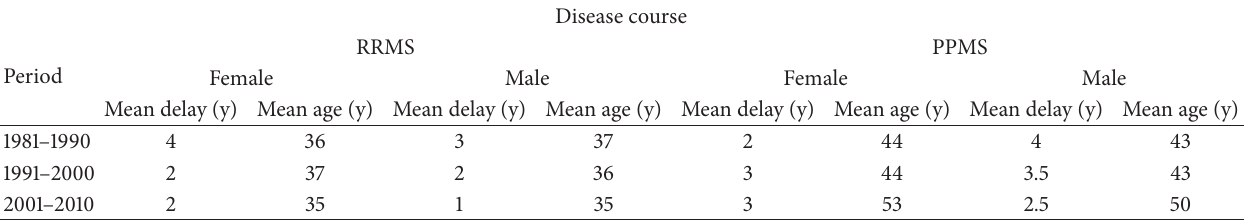
Table 3: Mean age at diagnosis and diagnostic delay (years) presented by disease course and gender during the study periods 1981–1990, 1991–2000, and 2001–2010.